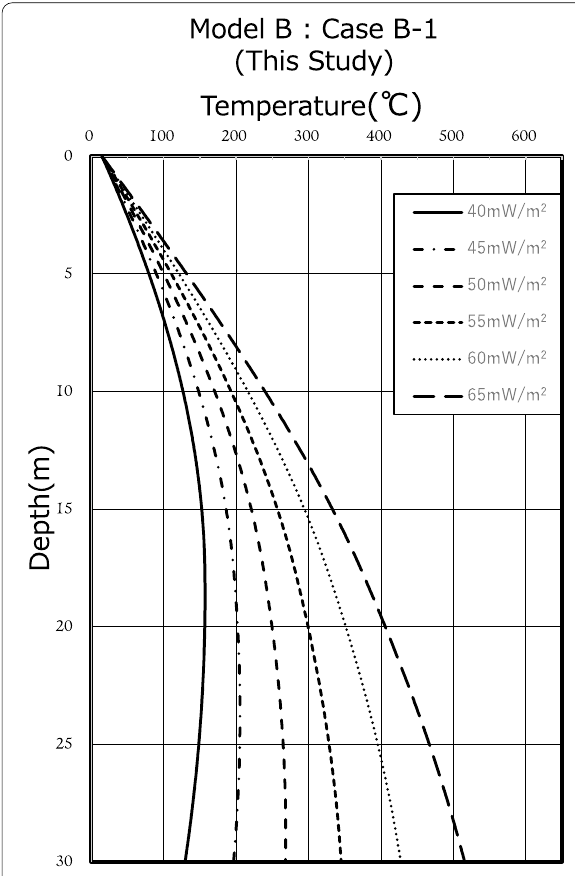
Fig. 12 Example of underground temperature calculation (3). Example calculation for Model B (Case B-1) with low heat flow.